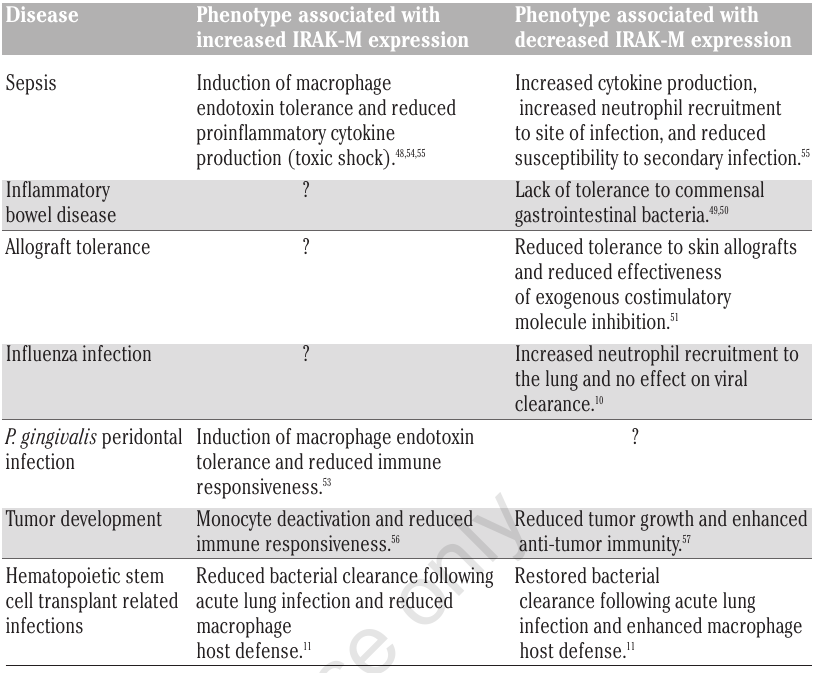
Table 4. Effect of IRAK-M expression on disease phenotypes.